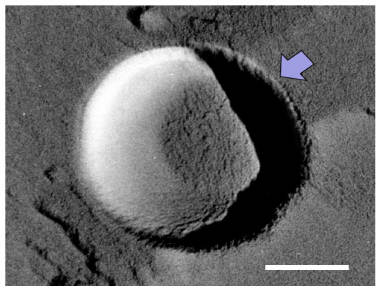
Figure 8. TEM image of a MNB in 1 wt % NaCl solution. Scale bar shows 100 nm. Arrow marks the thin layer on the